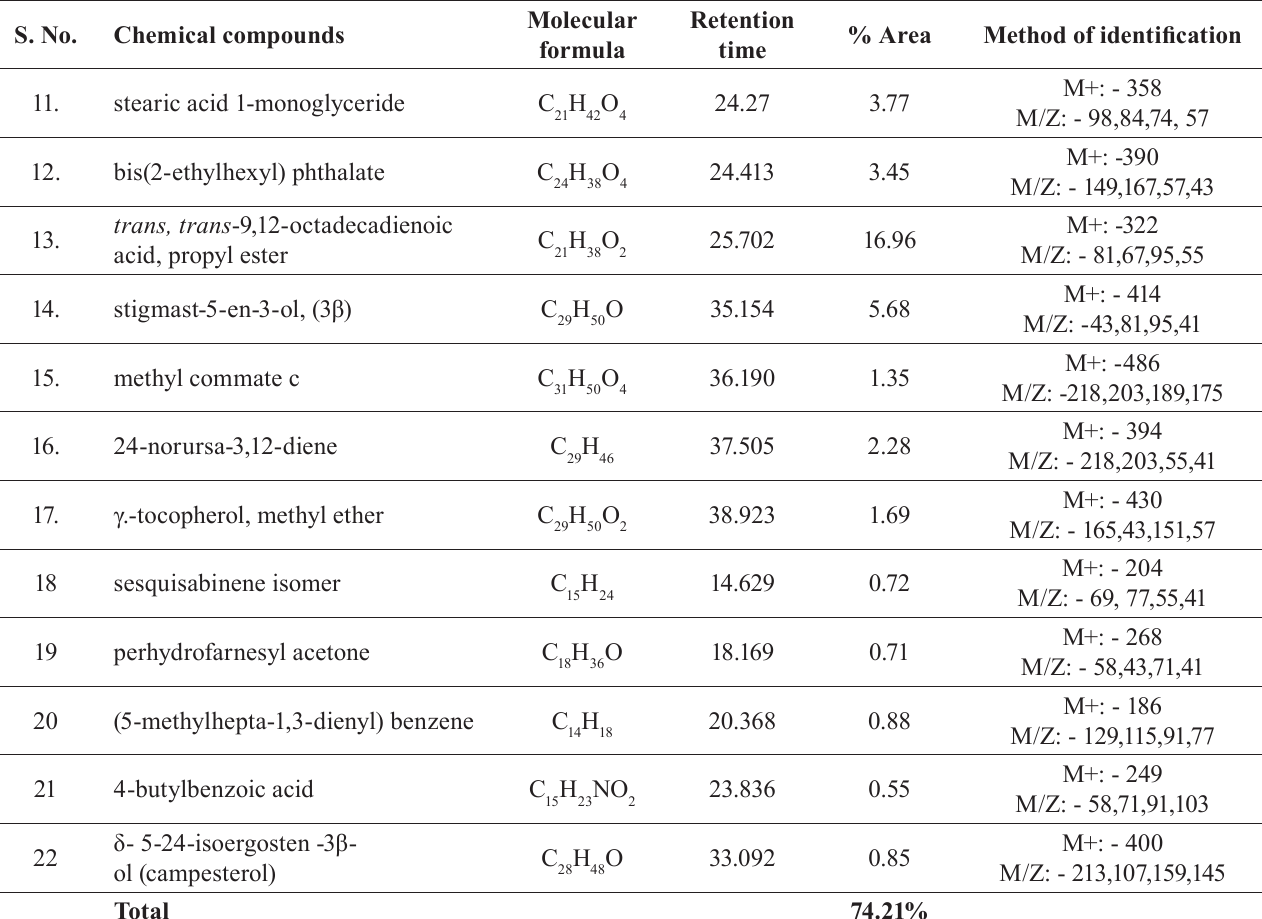
TABLE II - Chemical composition of methanolic extract of whole plant of A. uliginosa S.